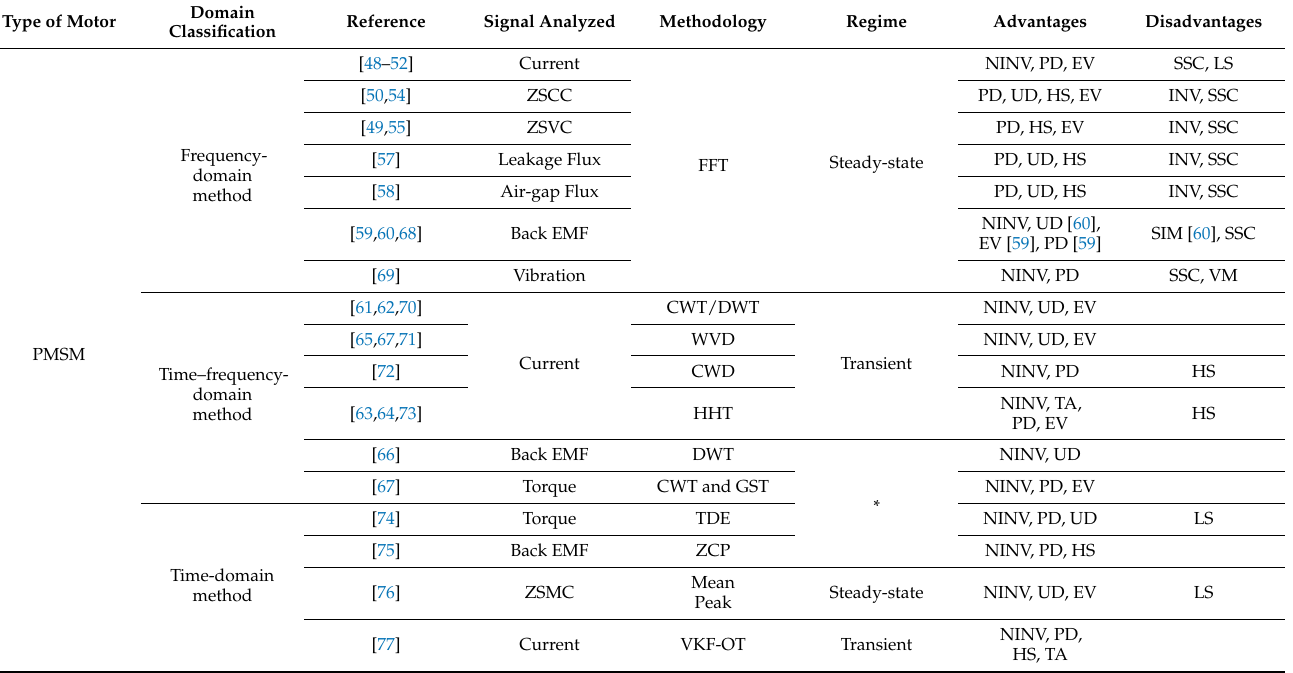
Table 2. Classification of detection methods for demagnetization faults in